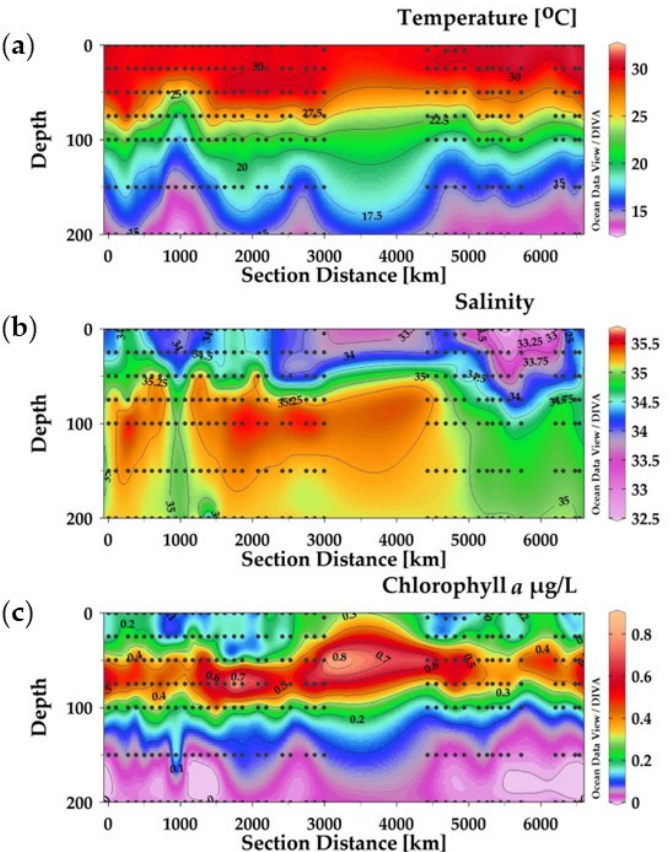
Figure 2. The vertical section of the temperature ( a ), salinity ( b ), and chlorophyll- a ( c ) in three tran- sects of the Eastern Indian Ocean.